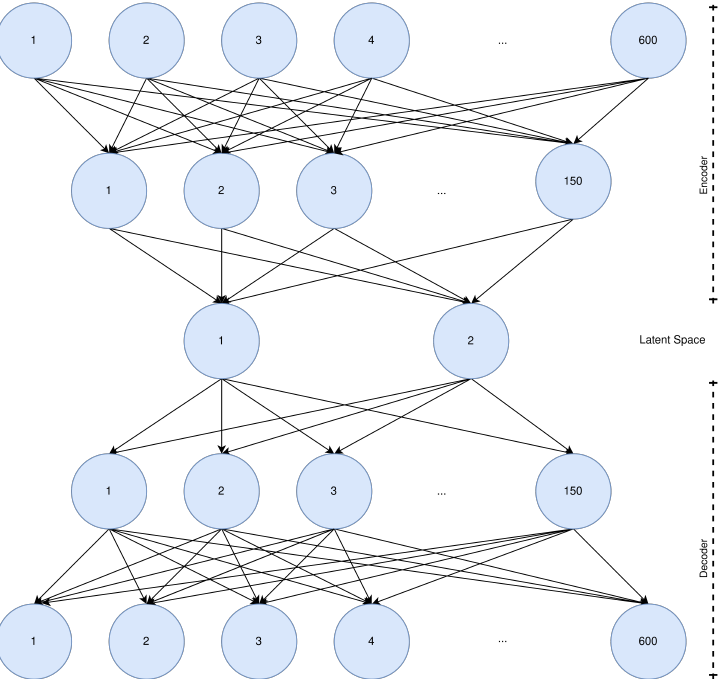
Figure 6. The autoencoder architecture used for dimensionality reduction. The first neuron of the latent space is the x -value and the second neuron of the latent space is the y